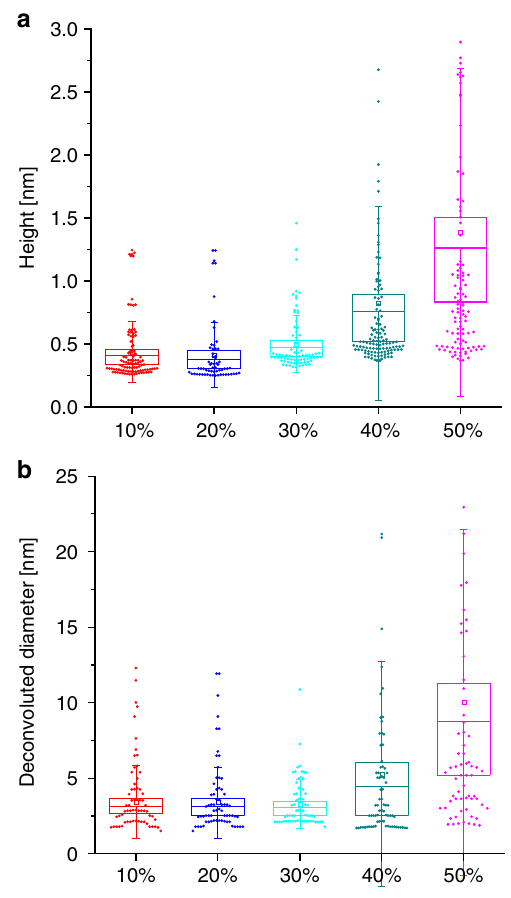
Fig. 4 Statistical analysis of aggregates present in different sucrose fractions. As represented by box charts of the a height and b the deconvoluted diameter of the A β 42 aggregates are shown. As the concentration of sucrose increase, the height as well as the diameter of individual aggregate increases. Source data of a and b are provided as